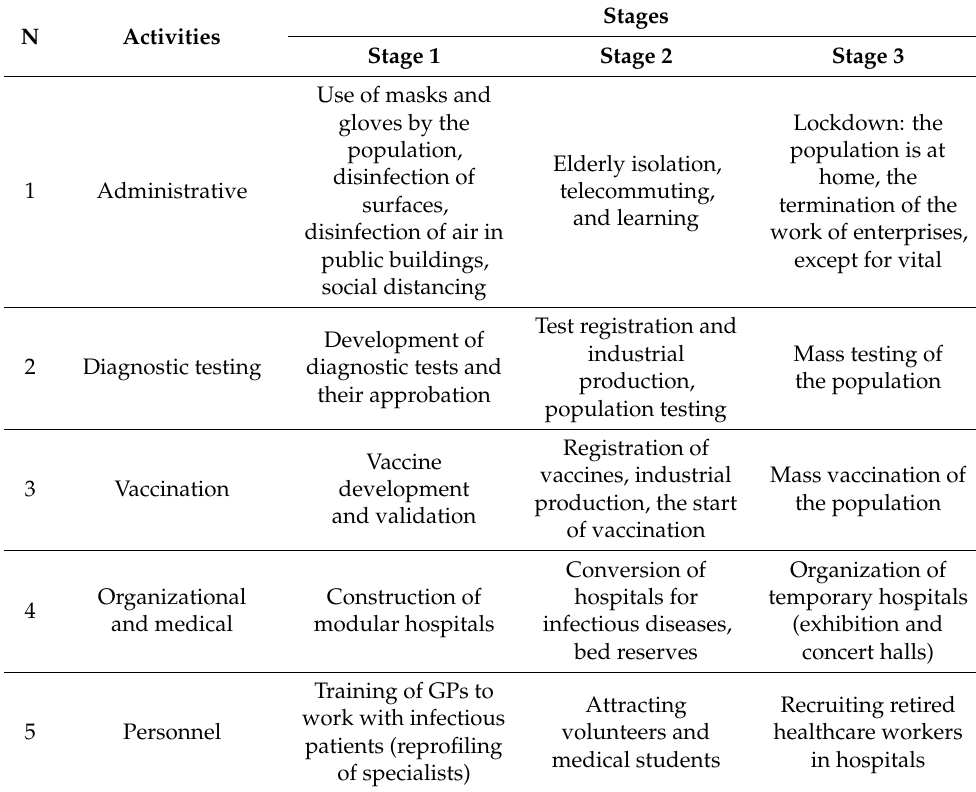
Table 4. Step-by-step measures adopted by Russian governmental bodies to combat COVID-19.